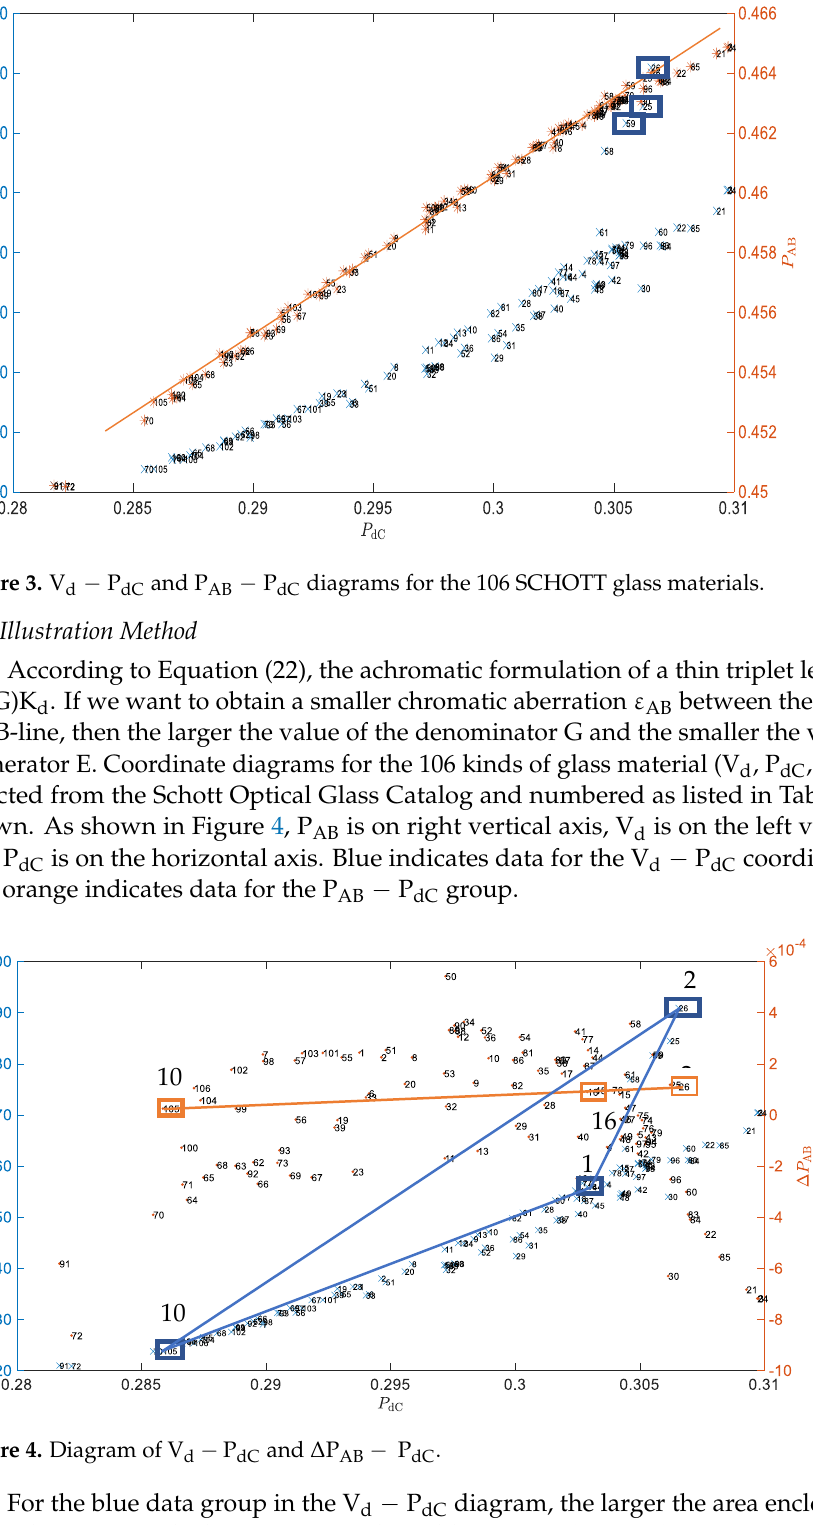
The illustration method was used to select eight triplet lens combinations. Figure 5 shows the chromatic aberration curve, in which the vertical axis shows the focal length shift  f S and the horizontal axis shows the wavelength.